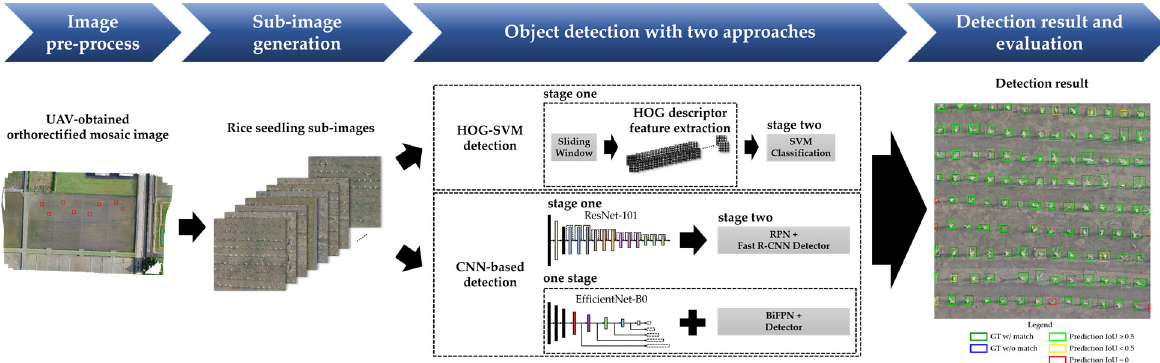
Figure 3. Sample images of rice seedlings in a paddy field image dataset [61]. Table 1. UAV imaging sensor details [61].